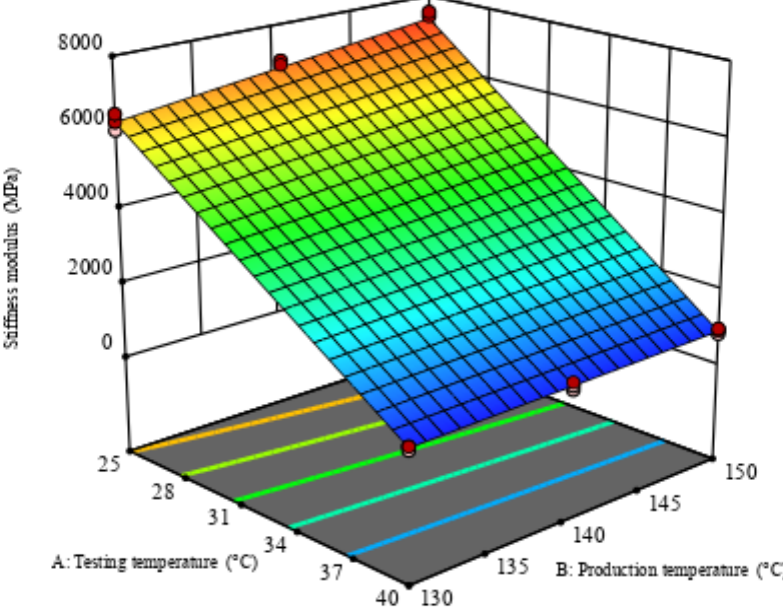
Figure 10. Plot of the interaction between the factors and the response of the 2FI model.